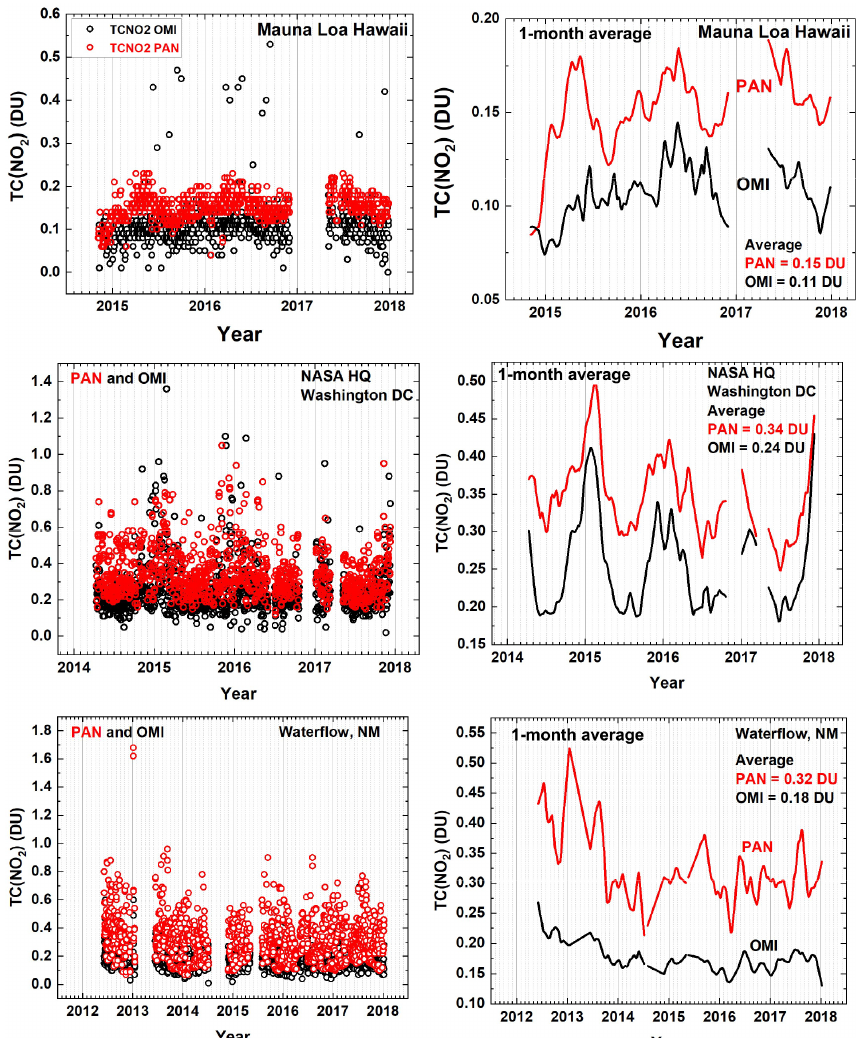
Figure 4. PANDORA compared to OMI. Extended TCNO 2 overpass time series for Mauna Loa Observatory, Hawaii, NASA Headquarters, Washington DC, and Waterflow, New